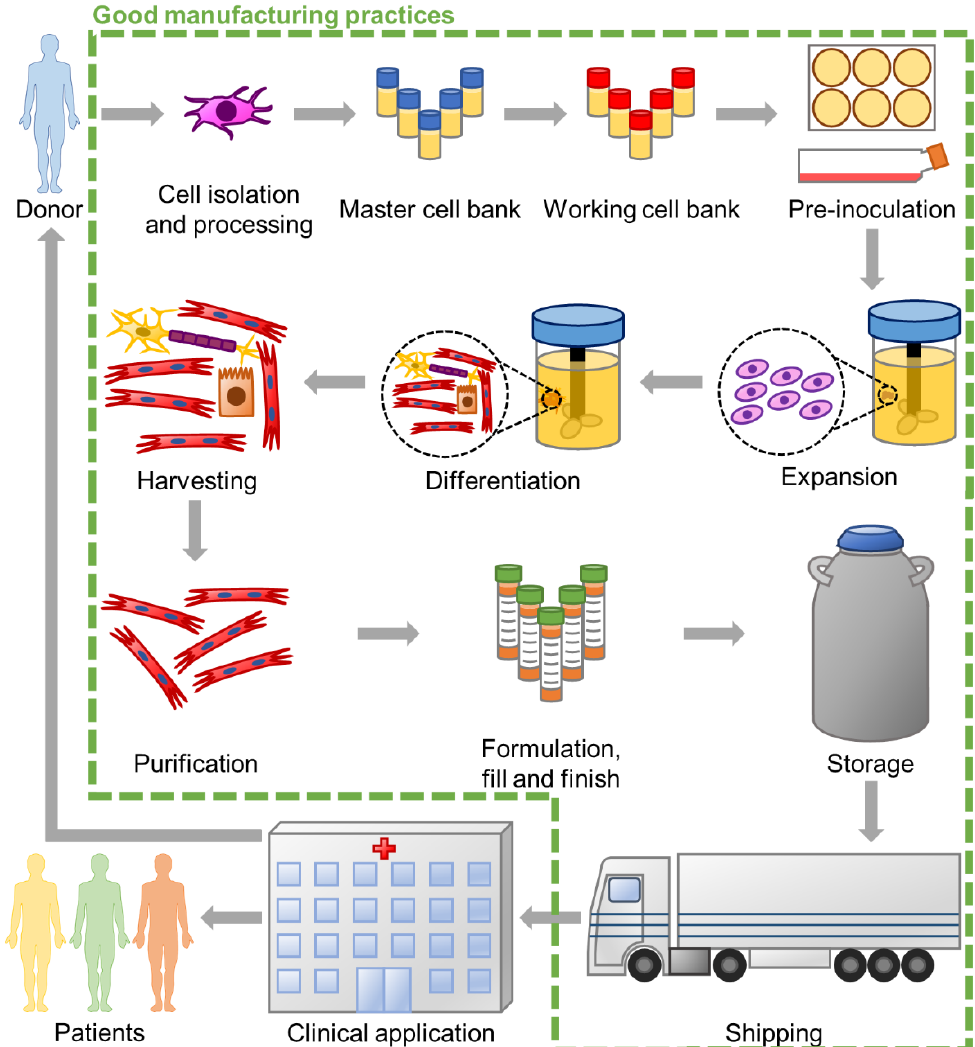
Figure 1. Process pipeline for the production and clinical application of a stem cell product (either autologous or allogeneic). European Medicines Agency legislation established good manufacturing practices to be applied from the initial cell isolation and processing to the product fill and finish while also requiring a clear definition of the storage and shipping conditions of the finished cell product. We note that the figure depicts a general stem cell product pipeline and, although most processes already at clinical scale do not perform yet differentiation in the bioreactors. However, we believe the field will move in that direction since using planar platforms will be hardly feasible at a clinical scale.